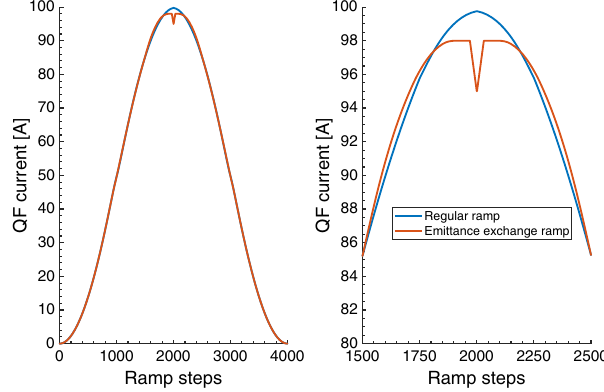
FIG. 12. QF-quadrupole family ramp to achieve emittance exchange. Nominal ramp is also shown for comparison. A short flat-top at 98 A is followed by a quick drop to 95 A over the last 30 ramp steps, leading to coupling resonance crossing. Left: Full ramp comparison. Right: Zoom of the modified part of the